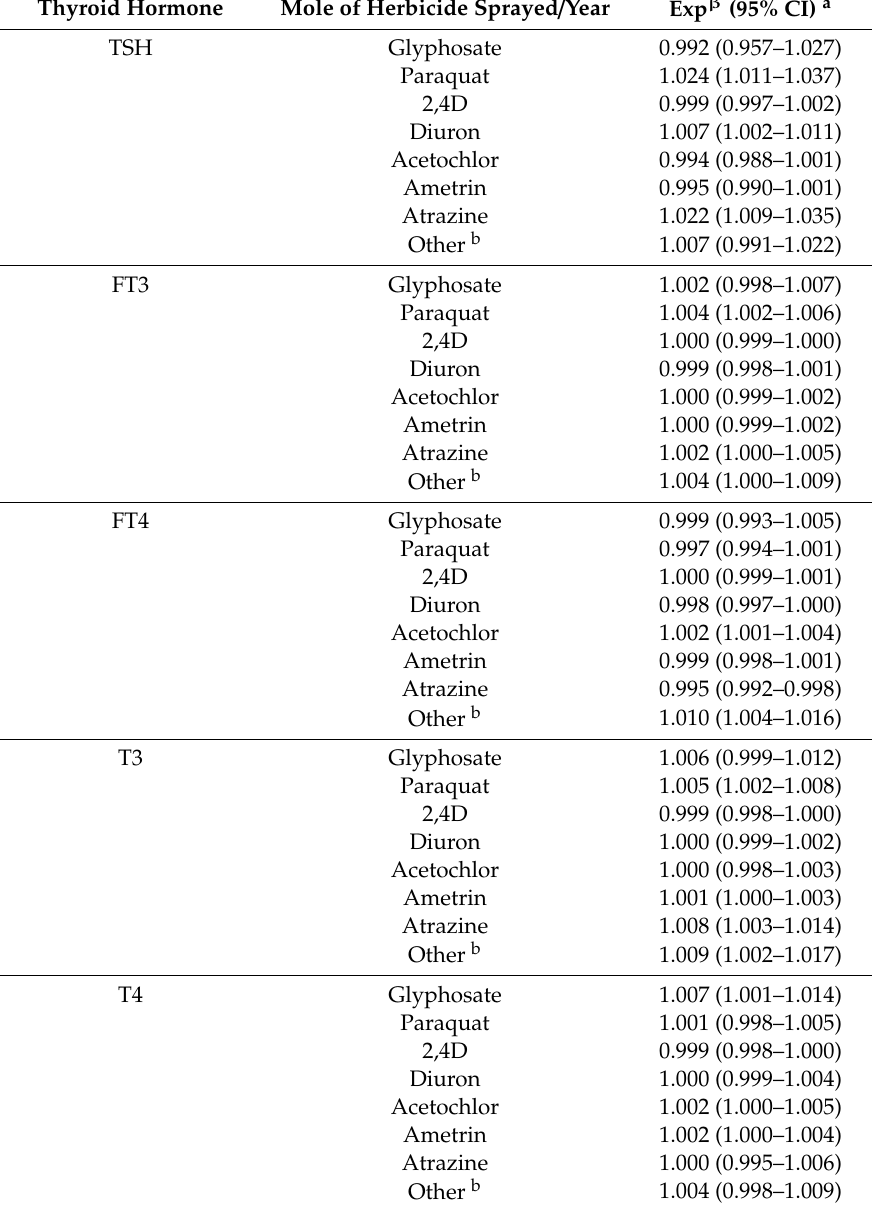
Table 6. Generalized linear regression models of log(e) thyroid hormone levels predicted by the moles of individual herbicide active ingredients sprayed in the past year for both conventional and organic farmers. Each row is a separate